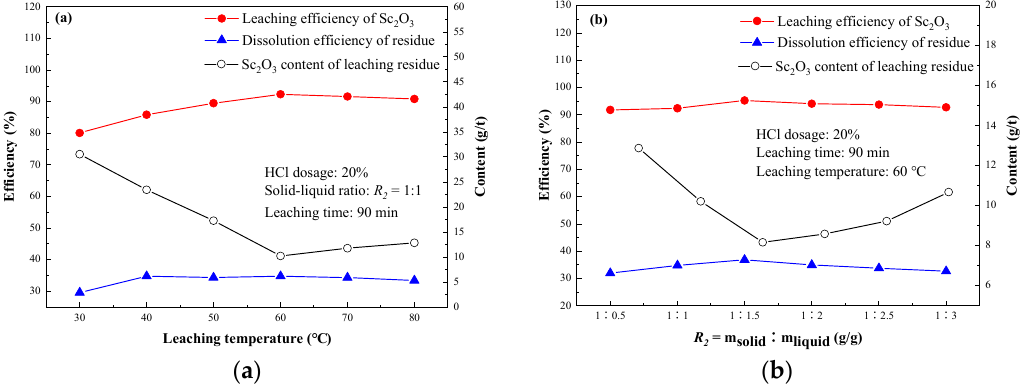
Figure 7. Effect results of leaching temperature ( a ) and leaching solid to liquid ratio ( b ) .